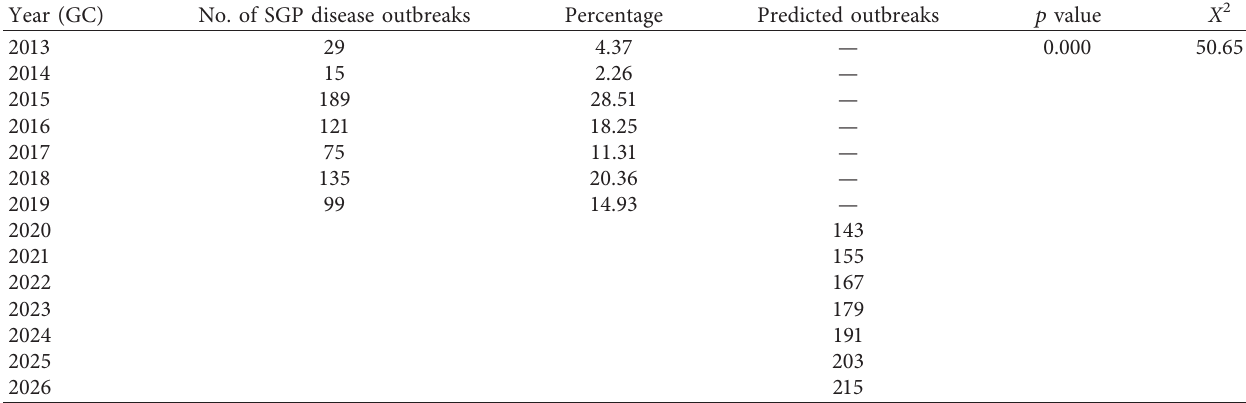
Table 2: Annual distribution of SGP disease in Eastern Amhara region from September 2013 to December 2019 and forecasted outbreaks.